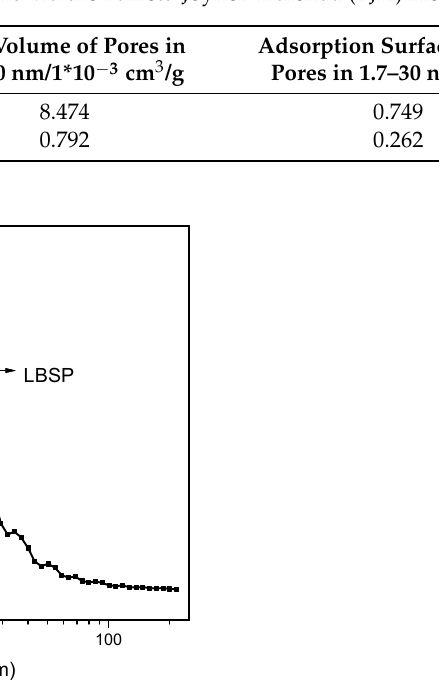
Table 4 and Figure 10, the surface area of the stone powder decreased from 21.7 nm to 6.6 nm after it was mixed with the PCE-1 solution. This pore size reduction is direct proof of the PCE-1 adsorption.